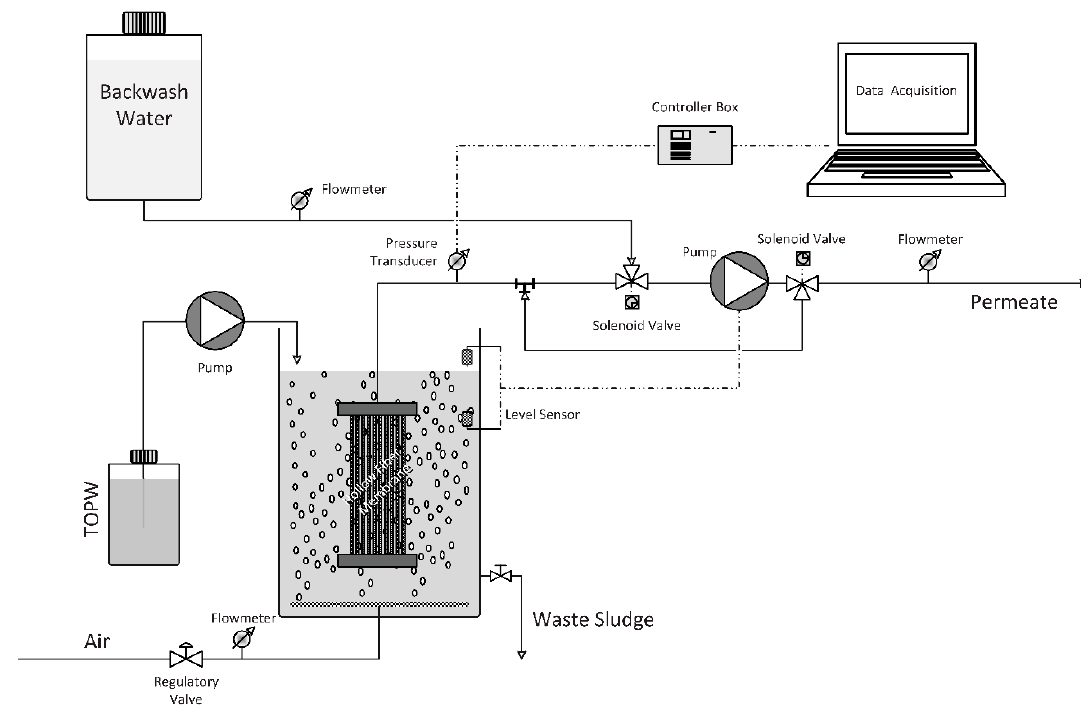
Figure 1. Schematic diagram of the laboratory scale submerged MBR system.